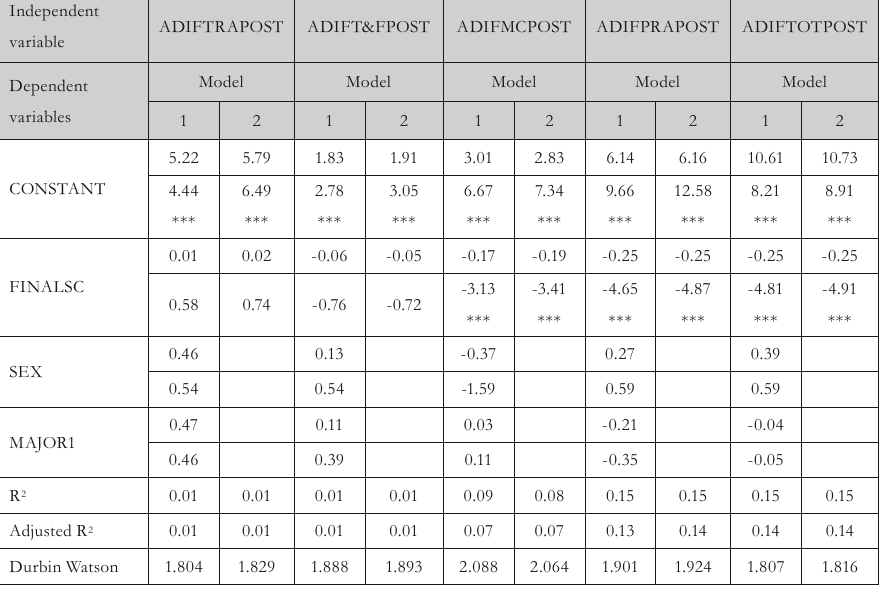
Tab. 3 – Results of the linear regression models for the post-examination of self-assessment, Source: based on our